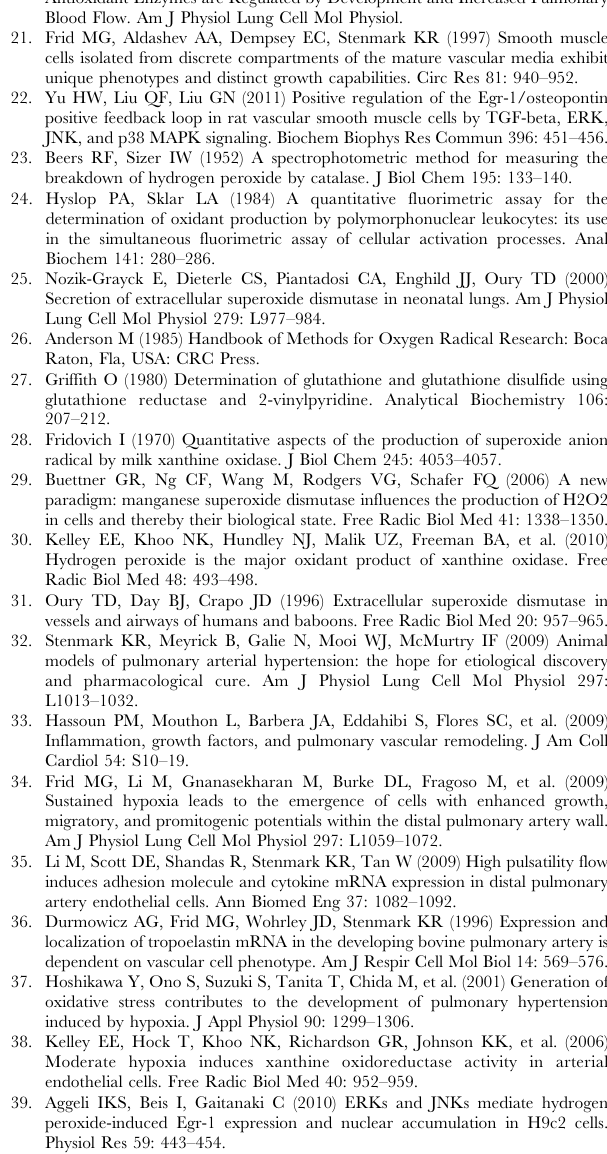
Figure S3 Combined treatment with SOD and CAT significantly inhibited XO induced Egr-1 expression. PASMC were pretreated with SOD (500 U/mL), Cat (600 U/ mL) or combined SOD + CAT for 30 minutes prior to xanthine oxidase (8 mU/mL) and hypoxanthine (0.5 mM) to evaluate the contribution of superoxide and hydrogen peroxide to Egr-1